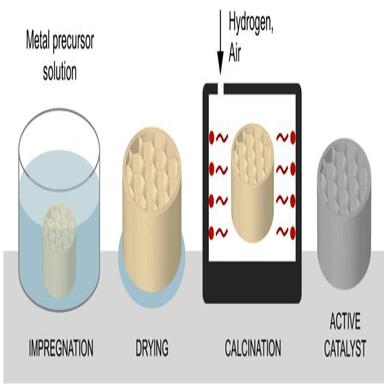
Method for catalyst active phase deposition on the 3D-printed supports.